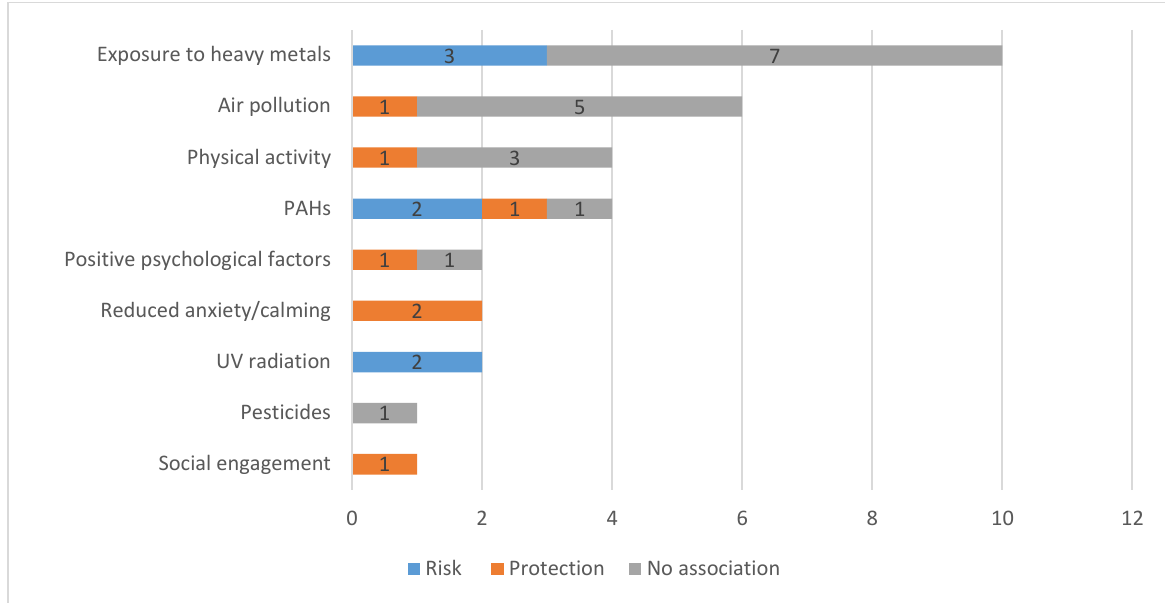
Figure 2. Contributors to the relation between green space and cancer investigated in the studies included ( n = 29).